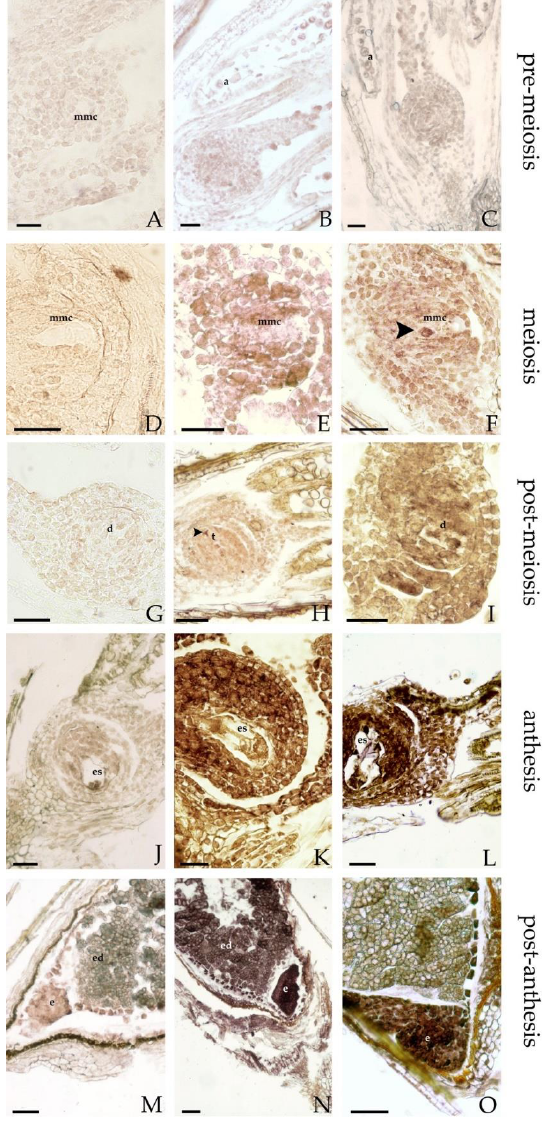
Figure 5 . APOSTART expression in longitudinal sections of flowers studied by ISH. Sections of sexual and apomictic genotypes were probed with DIG-labeled antisense ( B , C , E , F , H , I , K , L , N , O ) or sense ( A , D , G , J , M ) RNAs and viewed under a microscope bright field that gives a purple label. No signals were detected in the sections hybridized with the sense probes ( A , J , M sexual genotypes; D , G apomictic genotypes). B , C , longitudinal sections of ovules of sexual ( B ) and apomictic ( C ) genotypes containing the MMC, in both genotypes a poor hybridization signal was observed. In sexual ( E ) and apomictic ( F ) genotype ovules during megasporogenesis, the hybridization signal detected in the MMC was the same background in both genotypes, while in apomictic ovules a strong signal was observed in the aposporic cells (indicated by a black arrow) near the MMC ( F ). H , I , dyads and tetrads observed in ovules of sexual ( H ) and apomictic ( I ) genotypes have the same signal the background